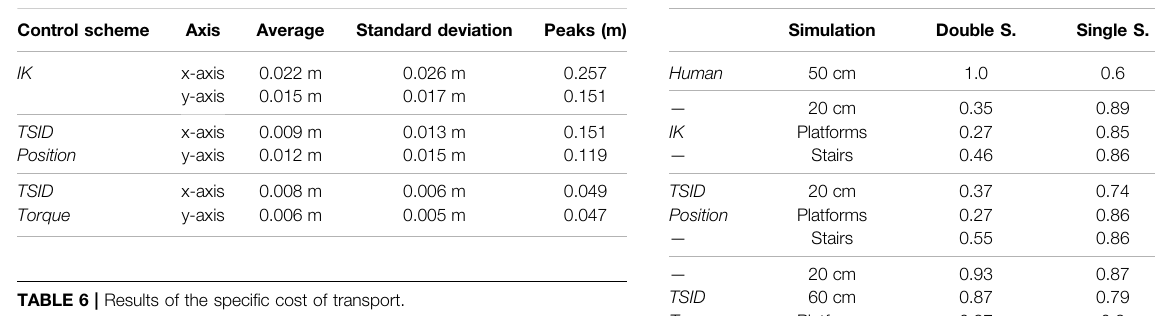
TABLE 6 | Results of the speci fi c cost of transport. Control Simulation